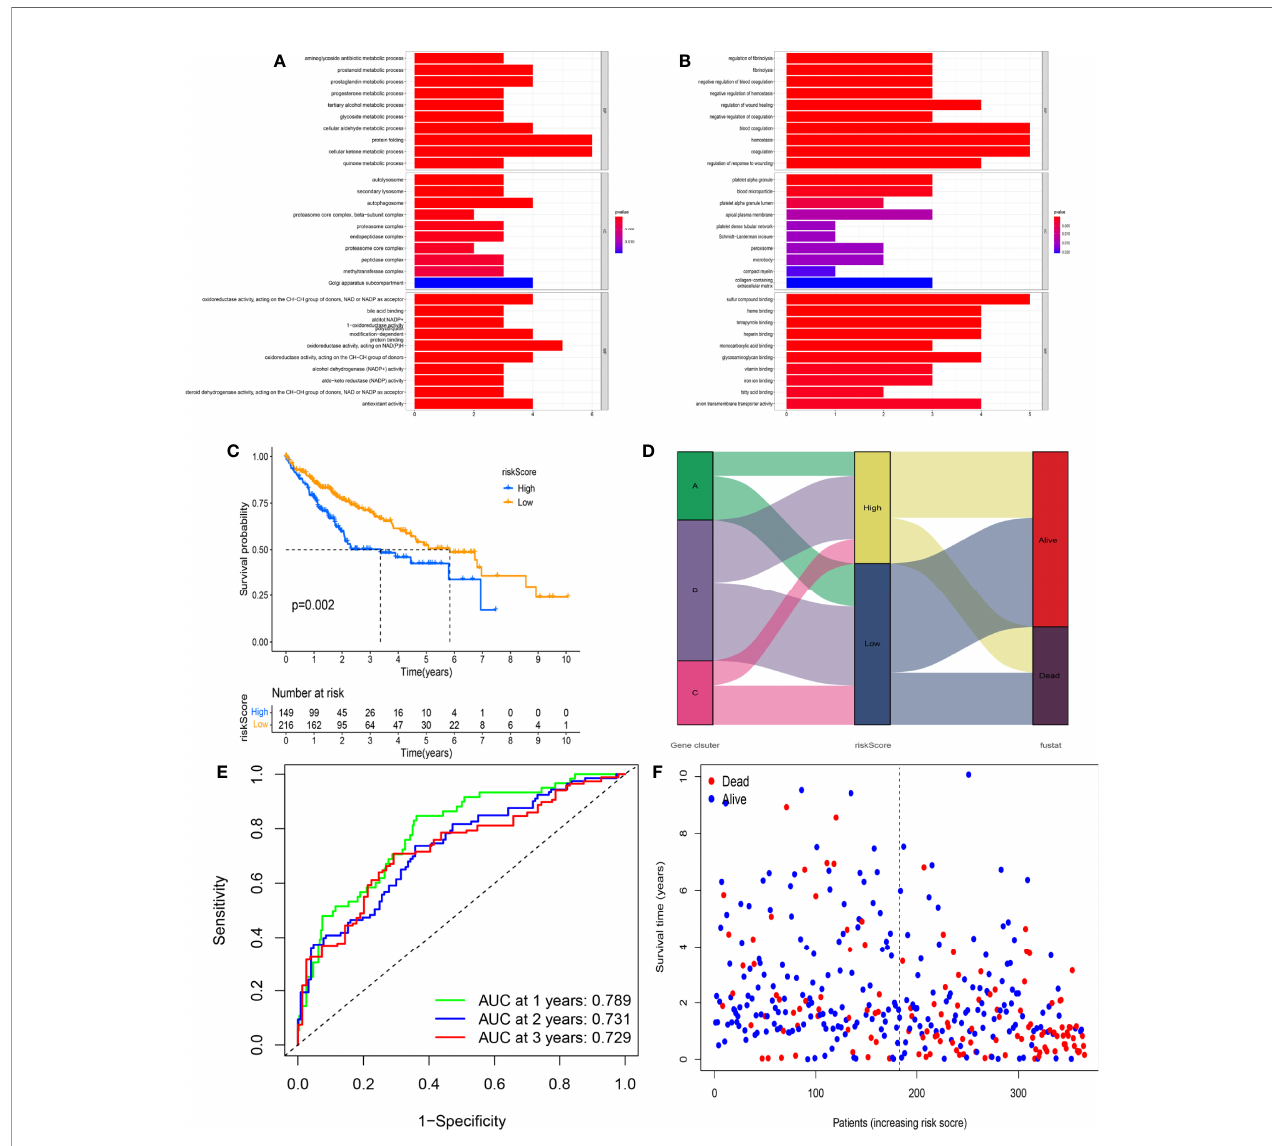
FIGURE 6 | Prognostic value of the novel risk score. (A) Gene Ontology (GO) enrichment analysis based on the gene expression differences among different genomic subtypes (p < 0.05). (B) GO enrichment analysis based on the gene expression differences among different genomic subtypes (p < 0.05). (C) The Kaplan – Meier (K-M) survival curve displays the difference in overall survival (OS) between different risk scoring groups. (D) The correlation between genomic subtypes, risk score, and survival status. (E) The time-independent receiver operating characteristic (ROC) curve of the risk score regarding OS. (F) The association of the risk score, survival time, and survival